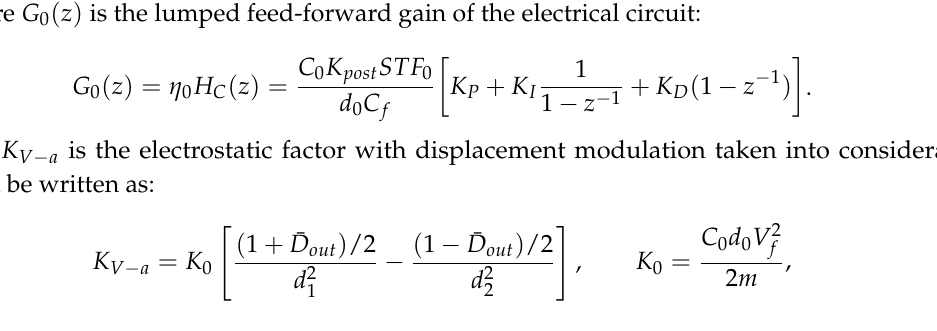
Figure 6. The simplified signal flow diagram to emphasize the local positive feed-forward